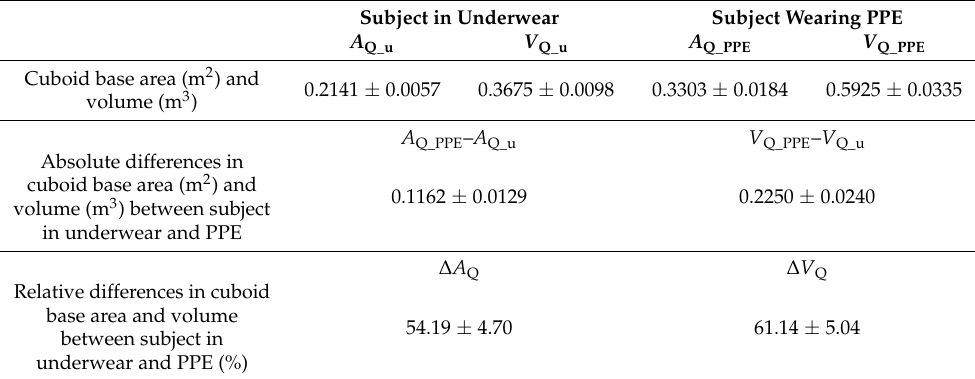
Table 5. Base areas and volumes of the human silhouette circumscribed by a cuboid as well as absolute and relative differences between the subject in underwear and